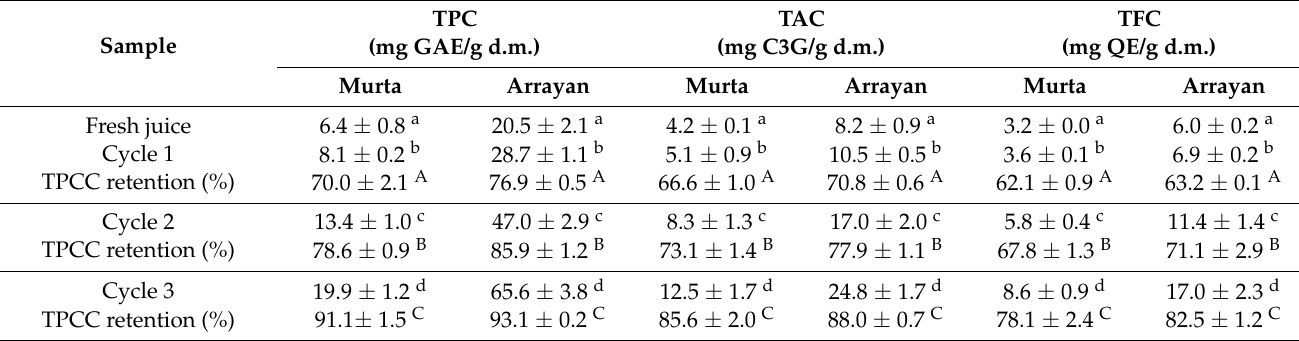
Table 2. Total phenolic compound content of fresh juices and cryoconcentrated